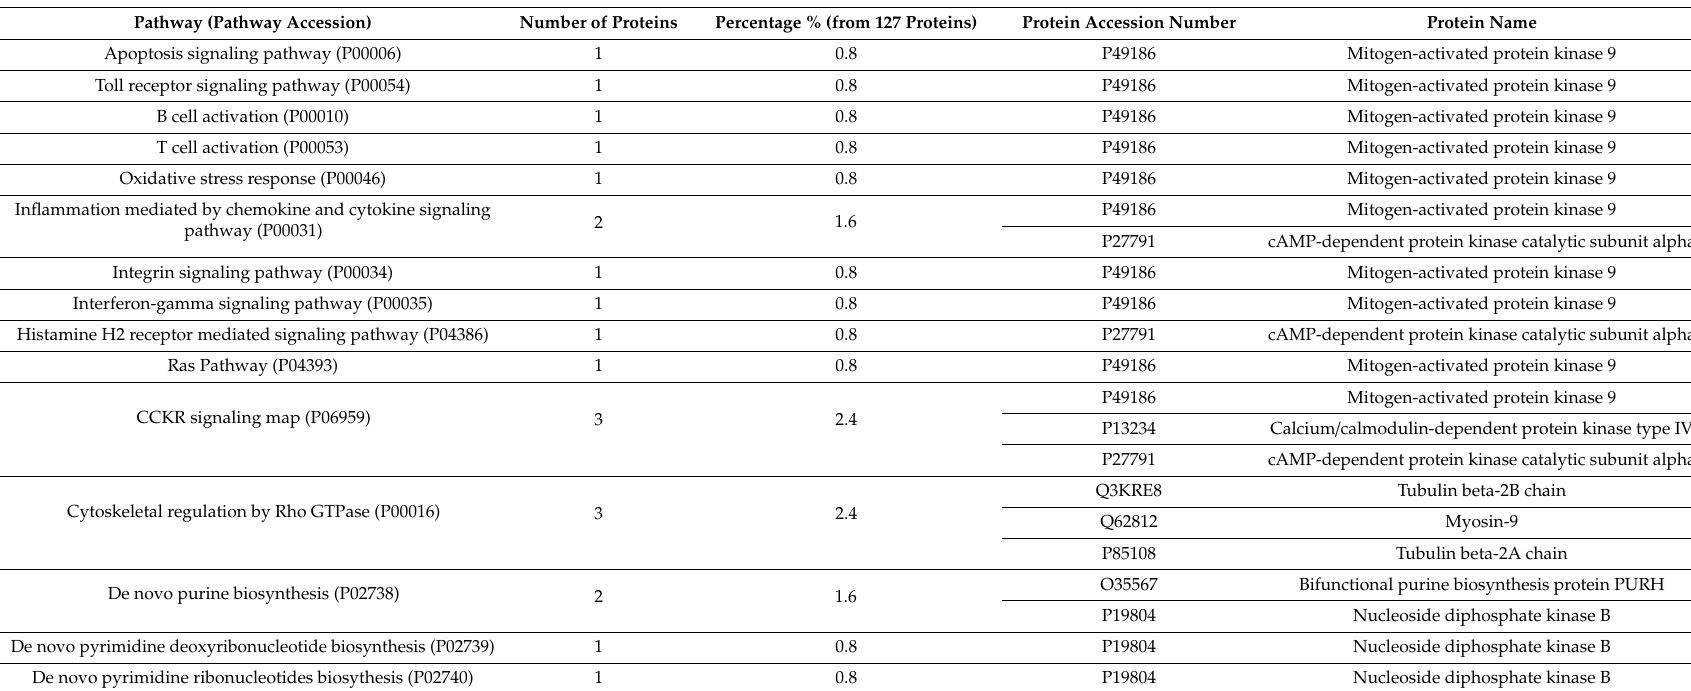
Table 3. Signaling pathways related to inflammatory, immune, apoptotic and cancerous processes identified by dysregulation of cerebral Proteins. The data were generated from PANTHER Classification